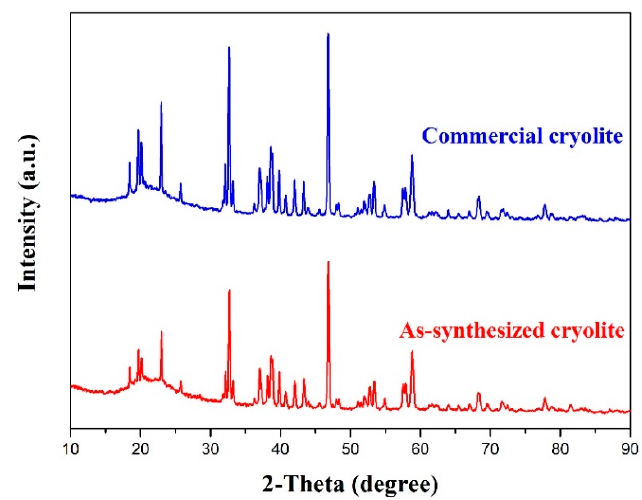
Figure 13. The XRD patterns of commercial cryolite and as-synthesized cryolite. Materials 2020 , 13 , x FOR PEER REVIEW